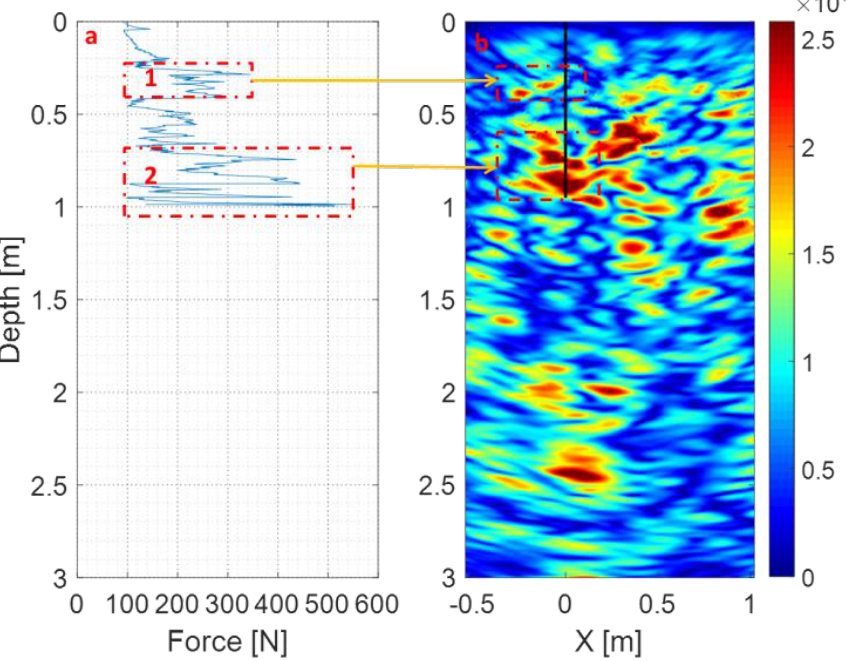
Figure 7. The detection result of LRPR. ( a ) The variable curve of the bit pressure with depth. Dotted boxes 1 and 2 represent the two areas with relatively higher bit pressure. ( b ) The imaging result which is applied data preprocessing, migration, exponential compensation gain, and to take the envelope of the image. The solid black line represents the drill pipe. Comparing ( a ) and ( b ), both results are exactly consistent.